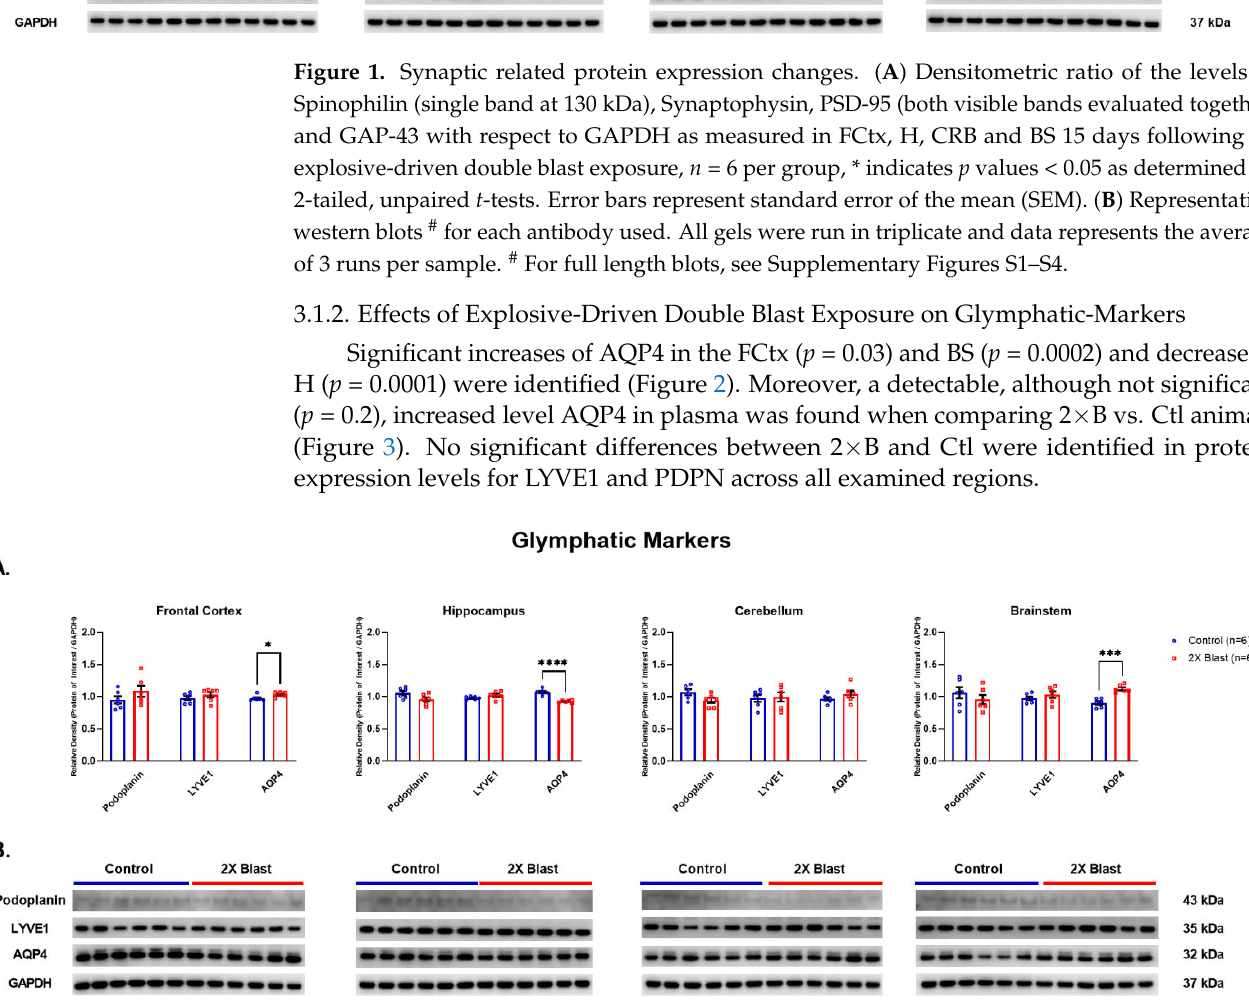
Figure 2. Glymphatic related protein expression changes. ( A ) Densitometric ratio of the levels of Podoplanin, LYVE1, and AQP4 with respect to GAPDH as measured in the FCtx, H, CRB and BS 15 days following an explosive-driven double blast exposure, n = 6 per group, * indicates p values < 0.05, *** indicates p values < 0.001 and **** indicates p values < 0.0001, as determined by 2-tailed, unpaired t -tests. Error bars represent standard error of the mean (SEM). ( B ) Representative western blots # for each antibody used. All gels were run in triplicate and data represents the average of 3 runs per sample. # For full length blots, see Supplementary Figures